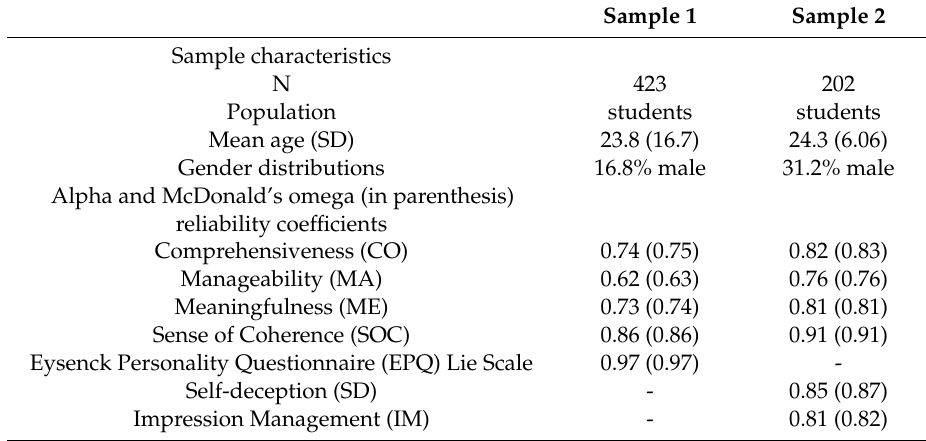
Table 1. Description of the samples and reliability coefficients for the Orientation to Life Questionnaire